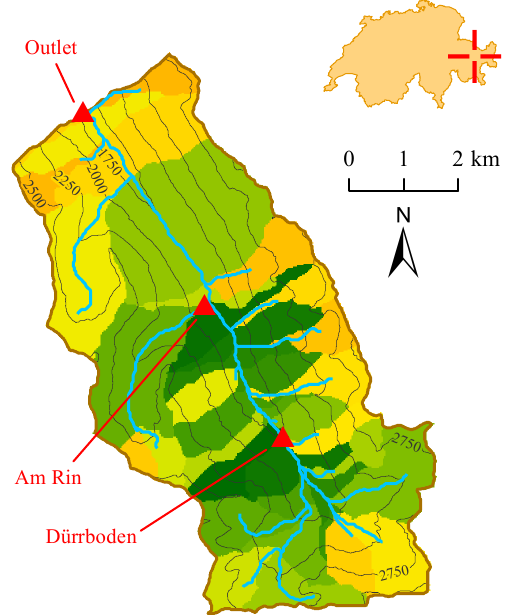
Figure 4. Map of the Dischma catchment displaying the subwater- sheds (coloured areas) and stream network (light blue line) derived from the DEM using TauDEM. The locations of the stream gauges are indicated as red